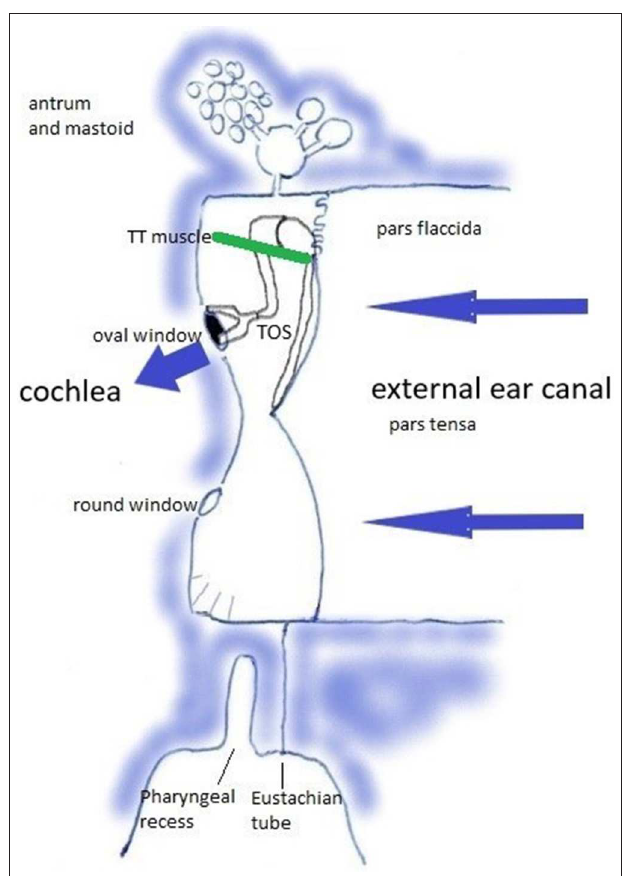
FIGURE 2 | The Tympano-Ossicular System. Blue arrows: sound wave transmission. Green line: tensor tympani muscle.